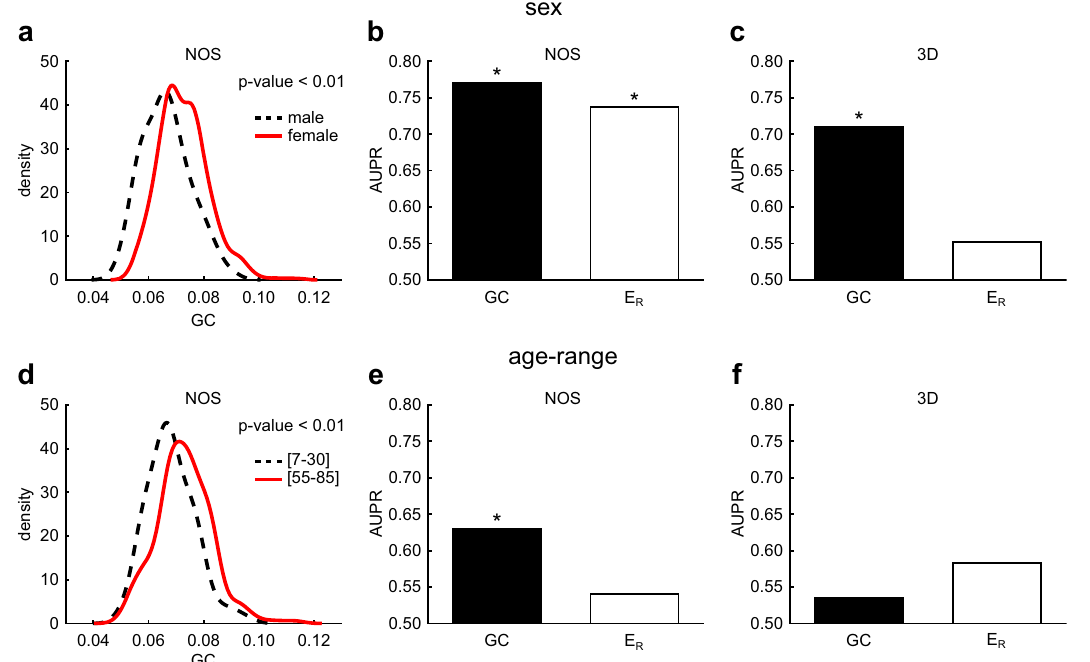
usingconnectionweightsbasedonNOS( b )or3D( c ).Anasteriskindicatesthatthe AUPR-trustworthiness 25 withBonferronicorrectionoverthe4markersissigni fi cant ( p -value<0.01). d Wehaverepeatedthesameanalysisasin( a ),butconsideringtwo groups of connectomes related to two age-ranges of the subjects: [7 – 30] (black dashed line) and [55 – 85] (red solid line). The p -value of the Mann – Whitney test shows that GC can signi fi cantly discriminate between connectomes of young and elderly subjects ( p -value < 0.01). e , f The barplots compare the AUPR of GC and E R methods in discriminating between connectomes related to two age-ranges, when using connectionweights basedon NOS ( e ) or 3D( f ).Anasterisk indicatesthatthe AUPR-trustworthiness with Bonferroni correction over the 4 markers is signi fi cant ( p -value <